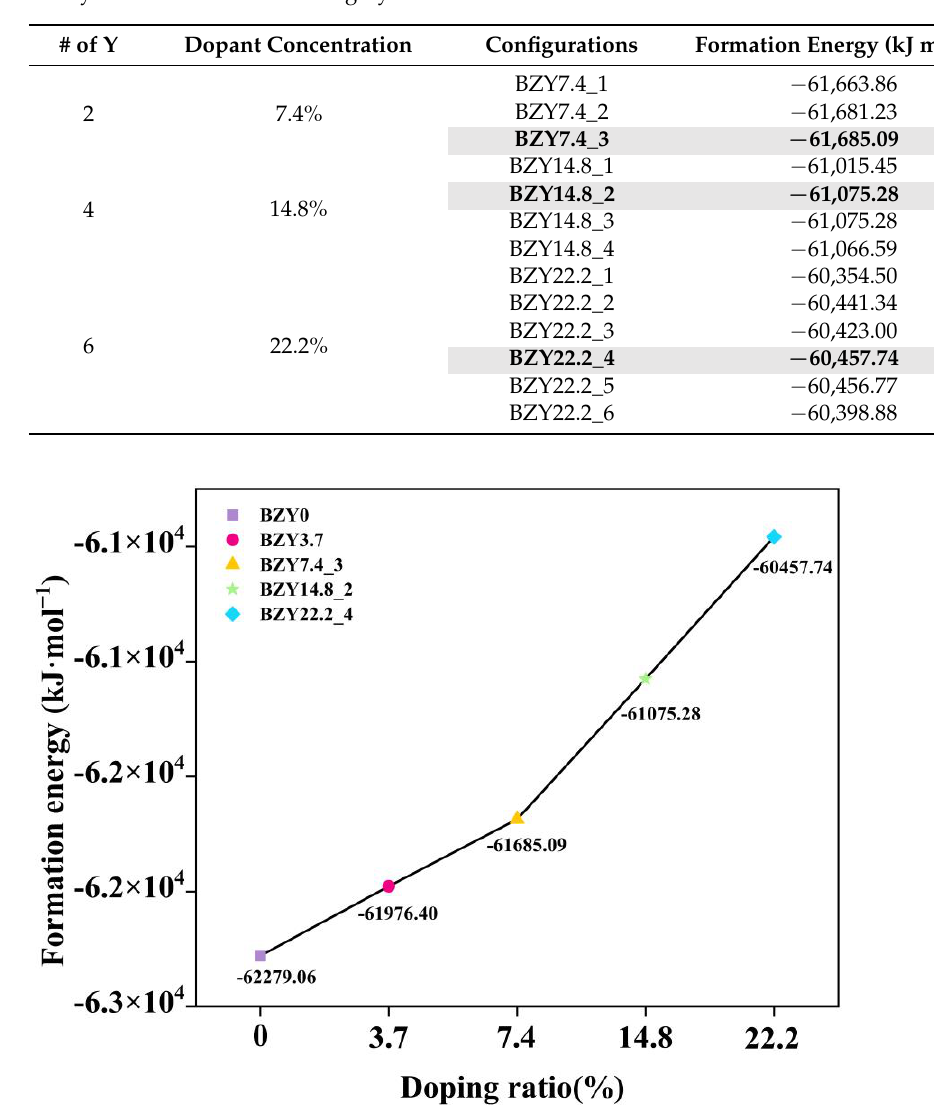
Figure 5. Relationship between doping ratio and formation energies in BaZr (1-x) Y x O 3- δ (BZY, x = 0, 0.037, 0.074, 0.148, and 0.22). Table 1. Formation energy of BZY structures with different doping contents; the structures screened out by the behaviors marked in gray are used for